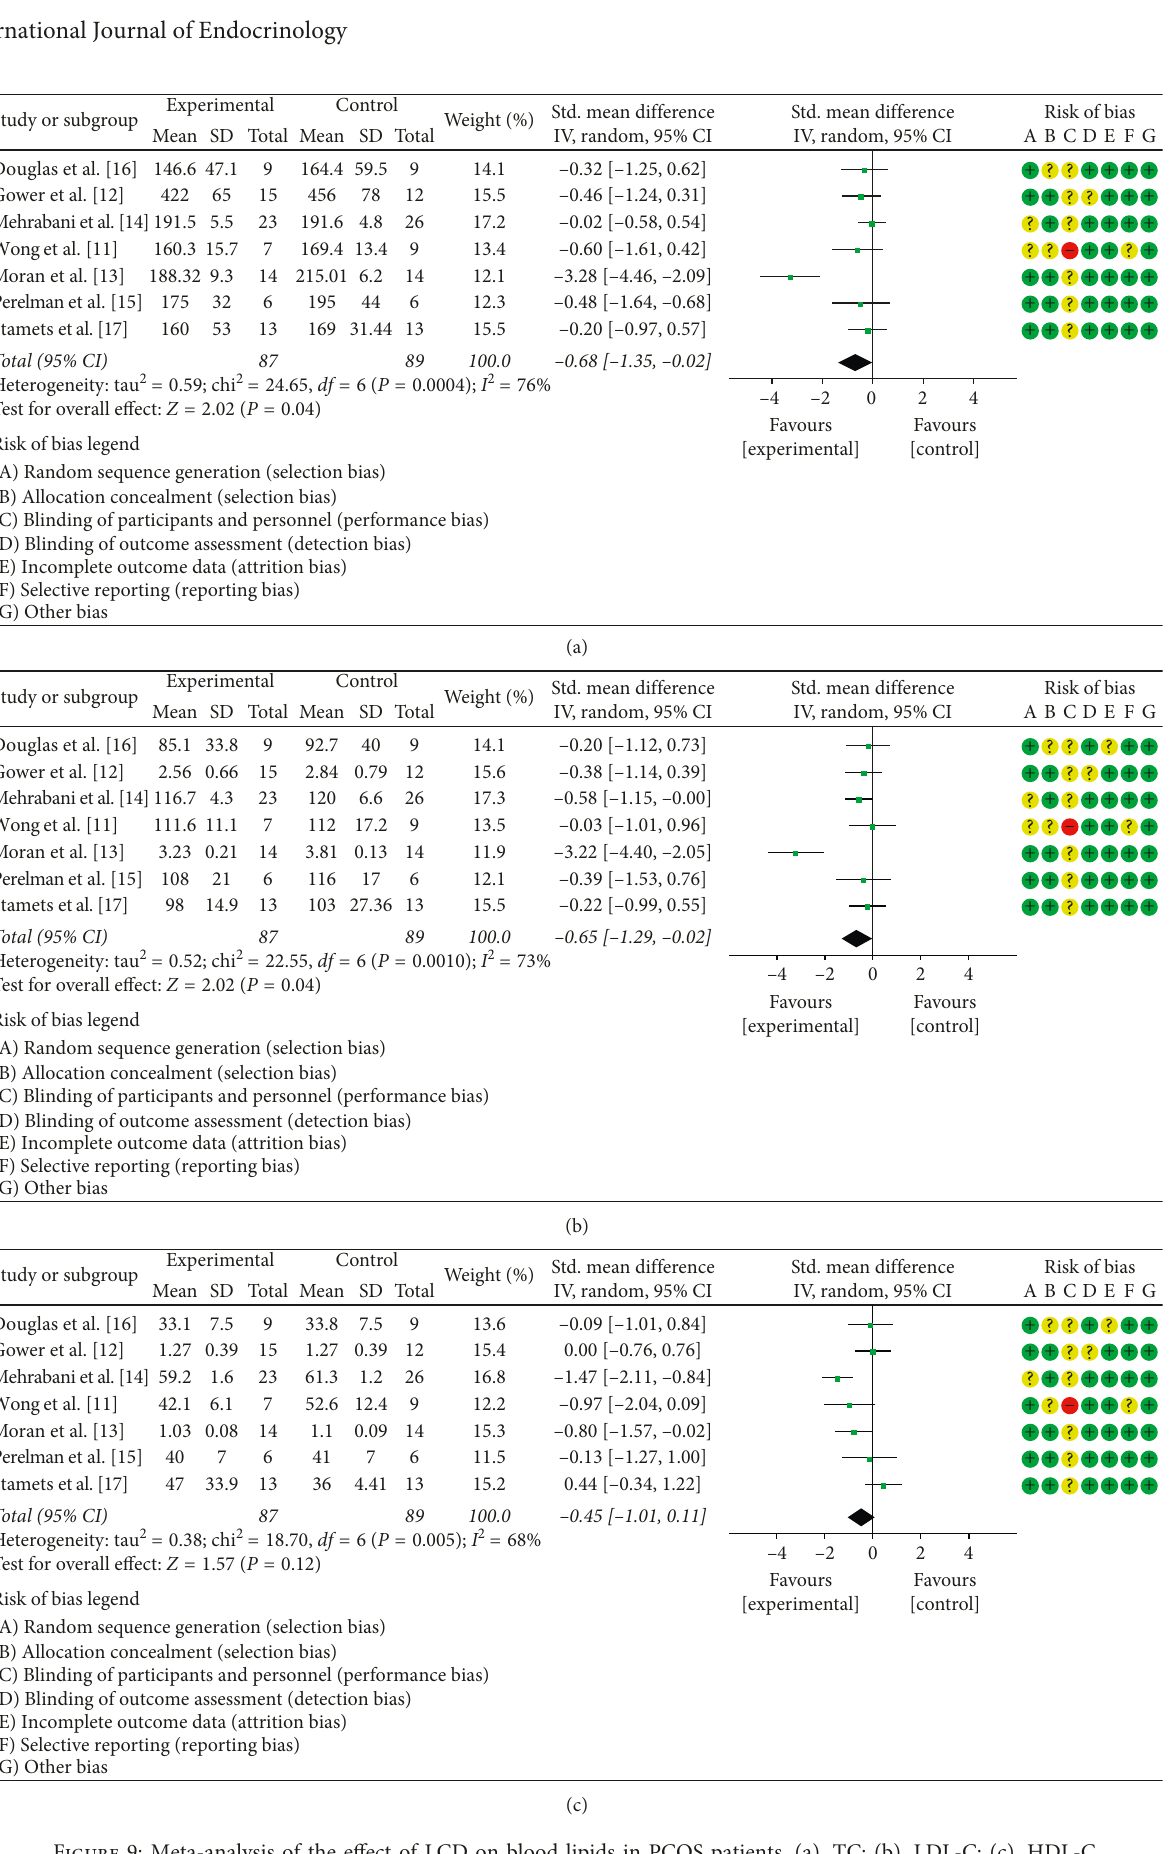
Figure 9: Meta-analysis of the effect of LCD on blood lipids in PCOS patients. (a), TC; (b), LDL-C; (c),